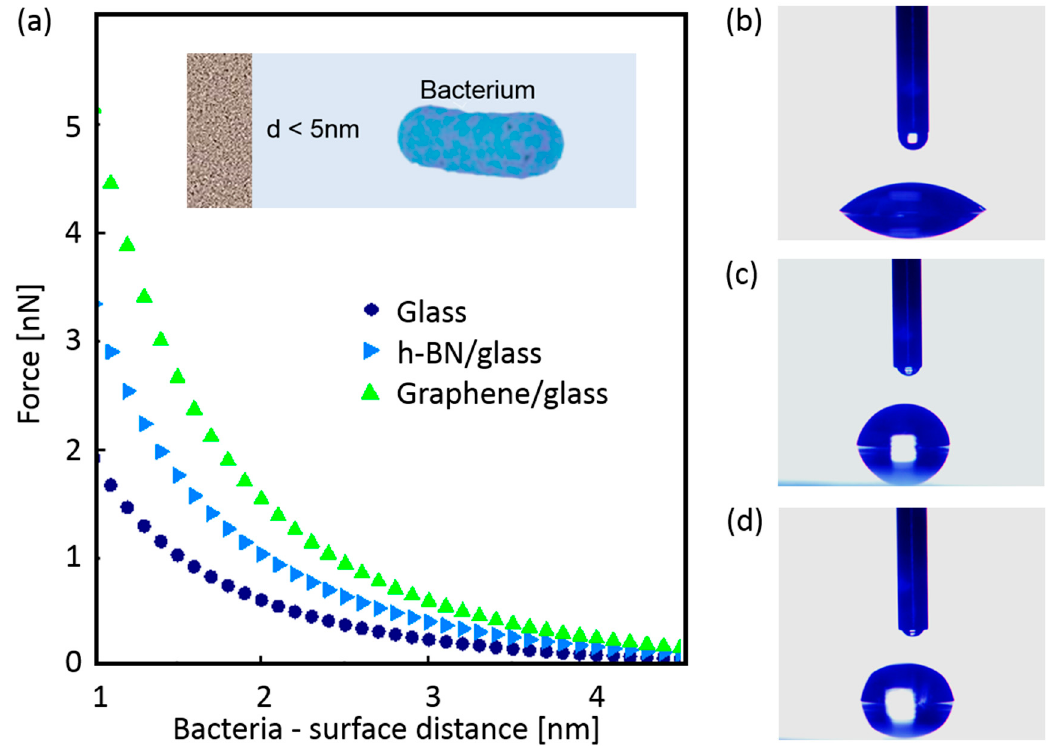
Figure 6. ( a ) Theoretical calculations of electrostatic force as a function of the distance between bacteria and surface (uncoated and coated glass samples). Images of contact angle measurements for ( b ) glass, ( c ) h-BN-coated glass, and ( d ) graphene-coated glass samples.